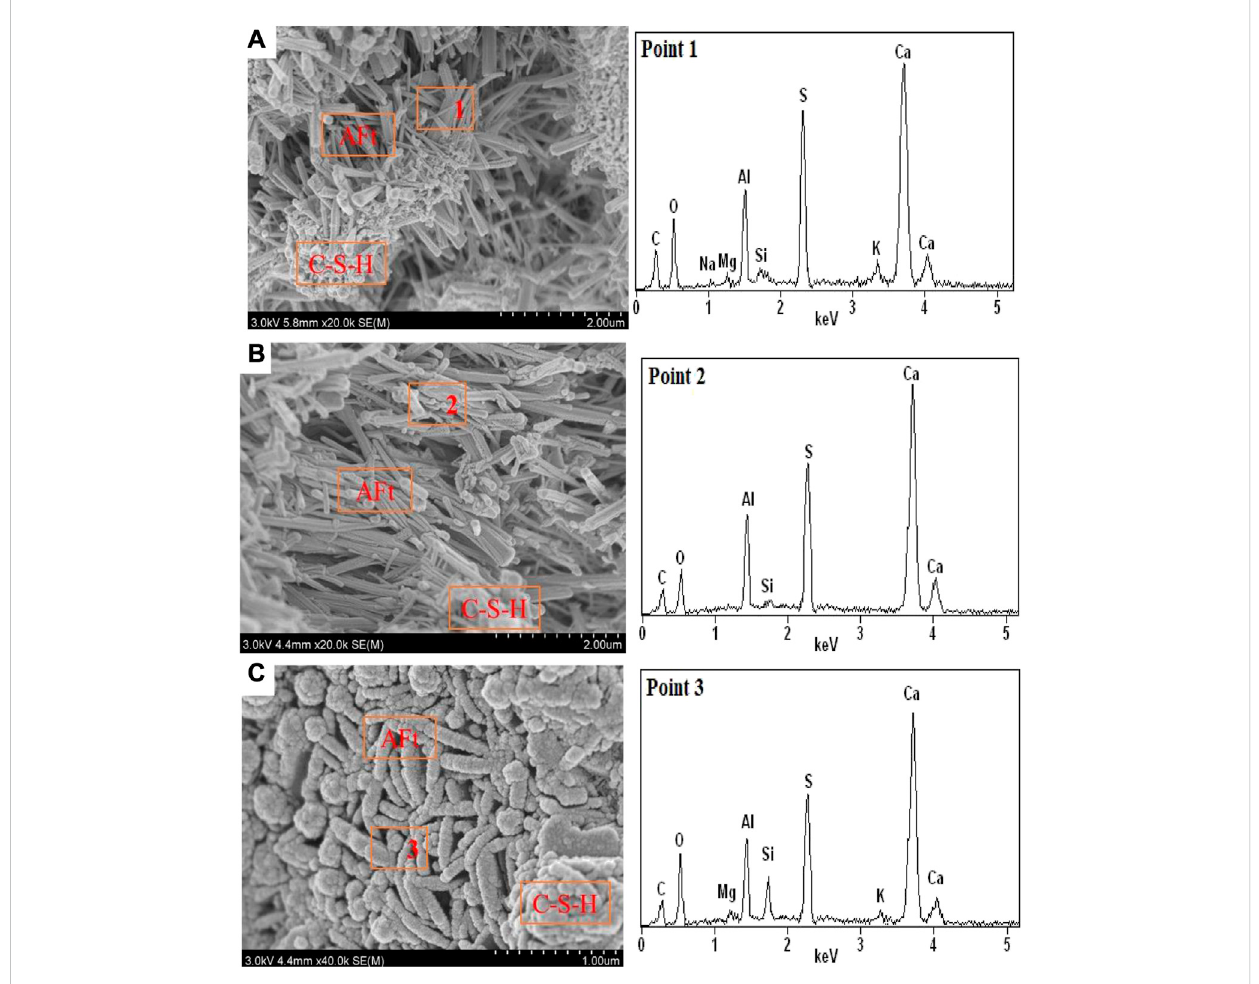
FIGURE 10 SEM-EDS images of hydration products of PSA paste at different ages. (A) 3 d; (B) 7 d; (C) 28 d.